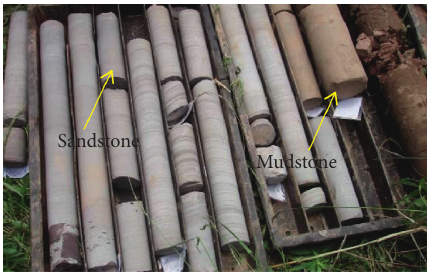
Figure 6: Core samples of mudstone and sandstone in site in- vestigation area ( H